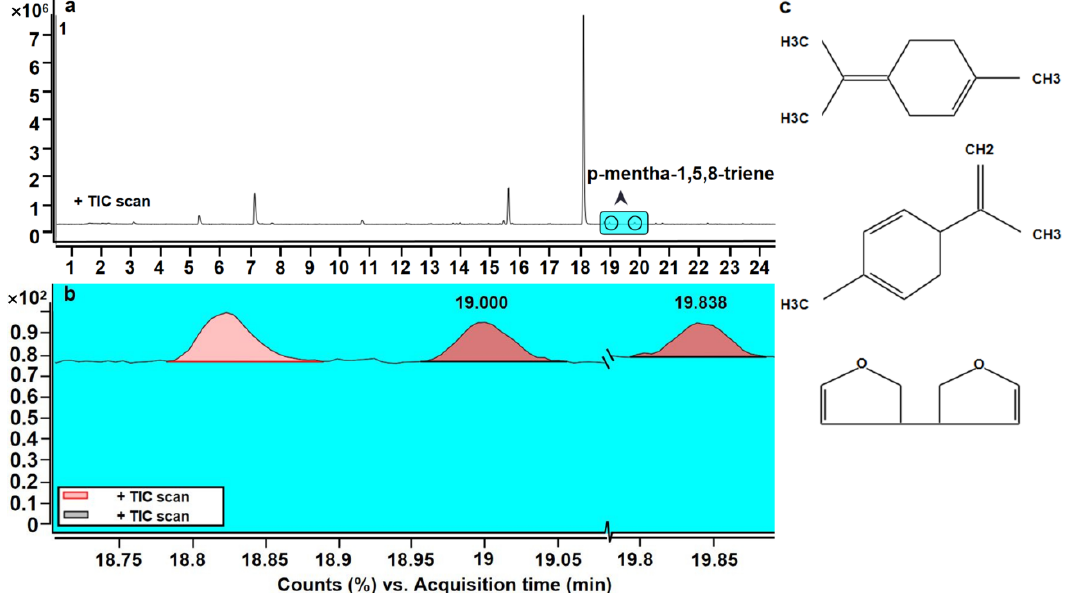
Figure 11. ( a ) Chromatogram of the on-vine group at 42 d. ( b ) Compound chromatography diagram. (overlaid) of p-mentha-1,5,8-triene (the peak at 19.000 and 19.838 min). ( c ) Molecular formulas of three isomers matched by NIST14 mass spectral database (p-mentha-1,5,8-triene, terpinolene and 3,3 ′ -bifuran,2,2 ′ ,3,3 ′ -tetrahydro- in proper order).